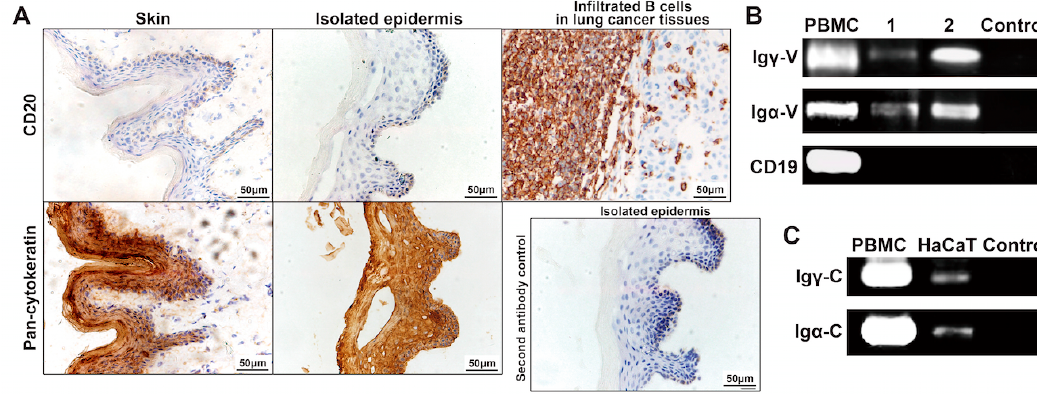
Figure 3. Transcription of IgG and IgA heavy chain gene in epidermal